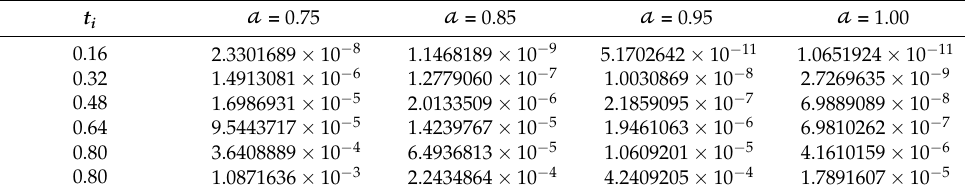
Table 2. The recurrence errors |W 8 ( x , t ) − W 7 ( x , t ) | of the tenth approximate solution for Example 1. t